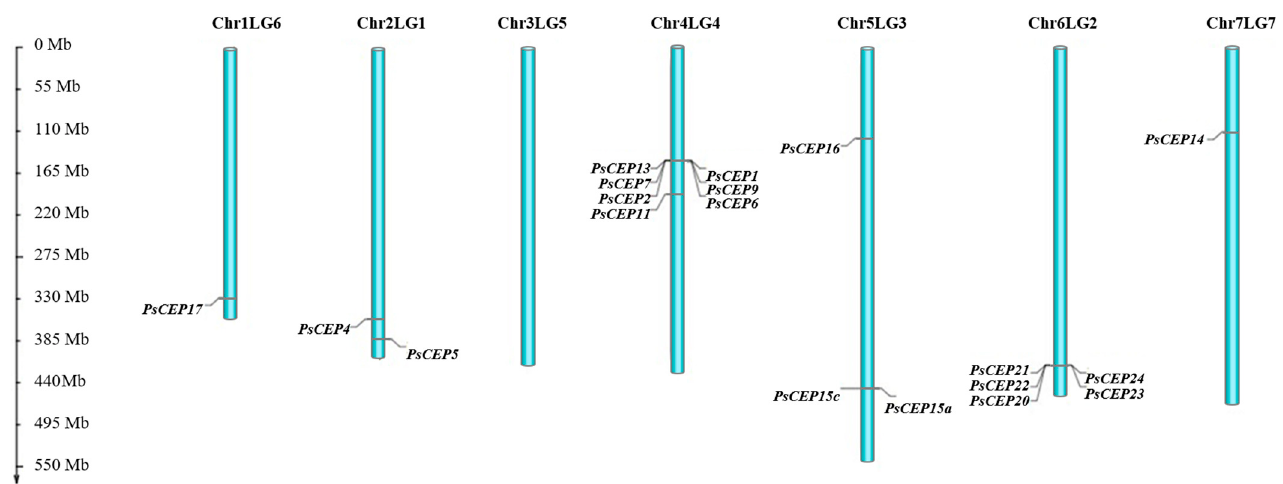
Figure 2. Chromosome localization of the PsCEP genes according to the INRA version of pea genome assembly. The positions of the PsCEP12 and PsCEP15b genes are not shown since the chromosome localization of these genes was not determined in the INRA version of pea genome assembly [20].